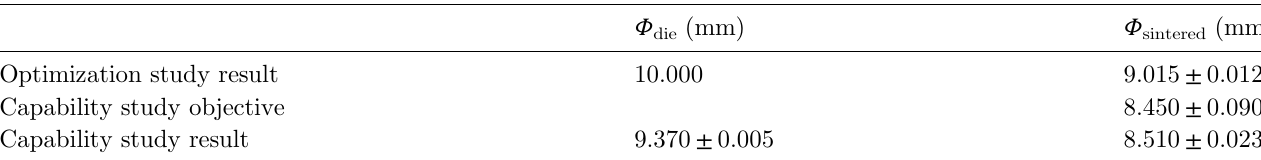
Table 3. Comparison between objective and result diameters, compared to trial number